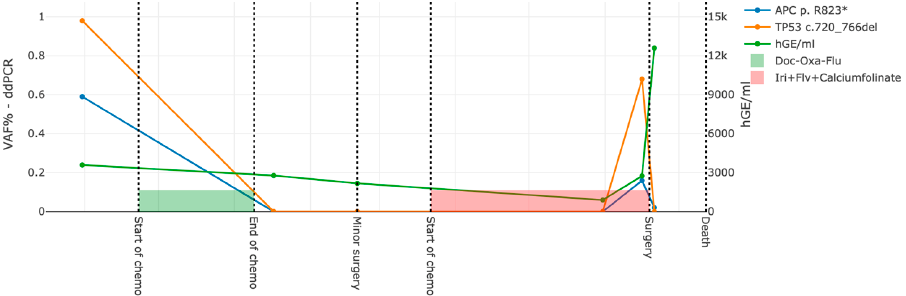
Figure 8. ddPCR detection in longitudinal plasma sampling. One example (P12) of ddPCR